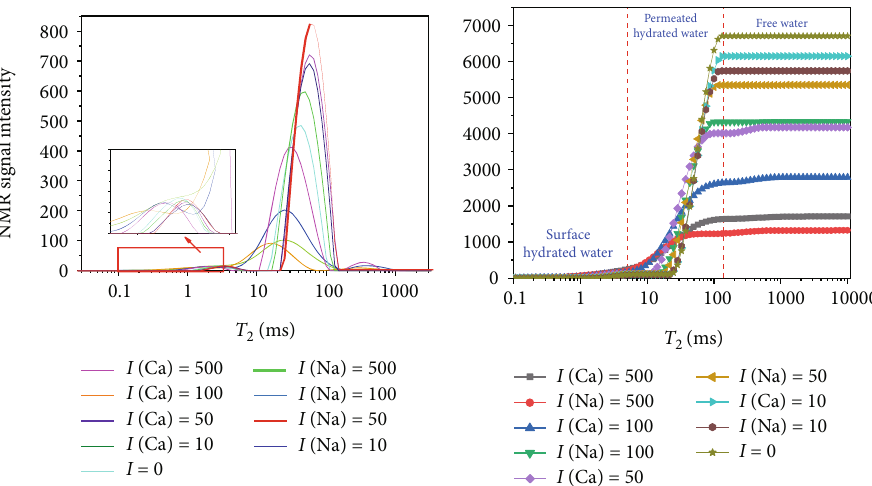
fi ed Ca-bentonite B2 at di ff erent ionic strengths.